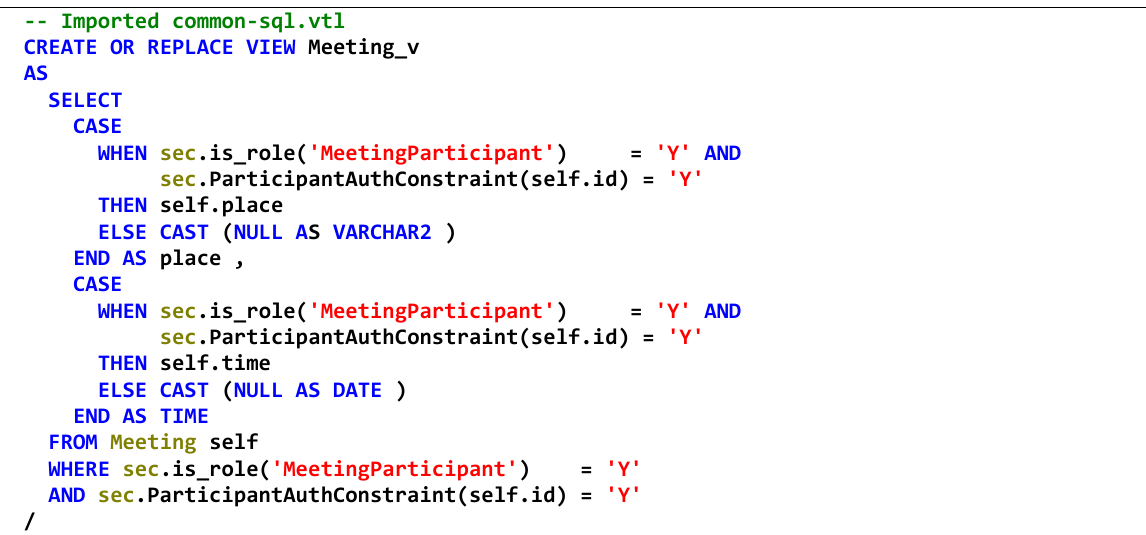
Figure 12. Transformed Select authorisation